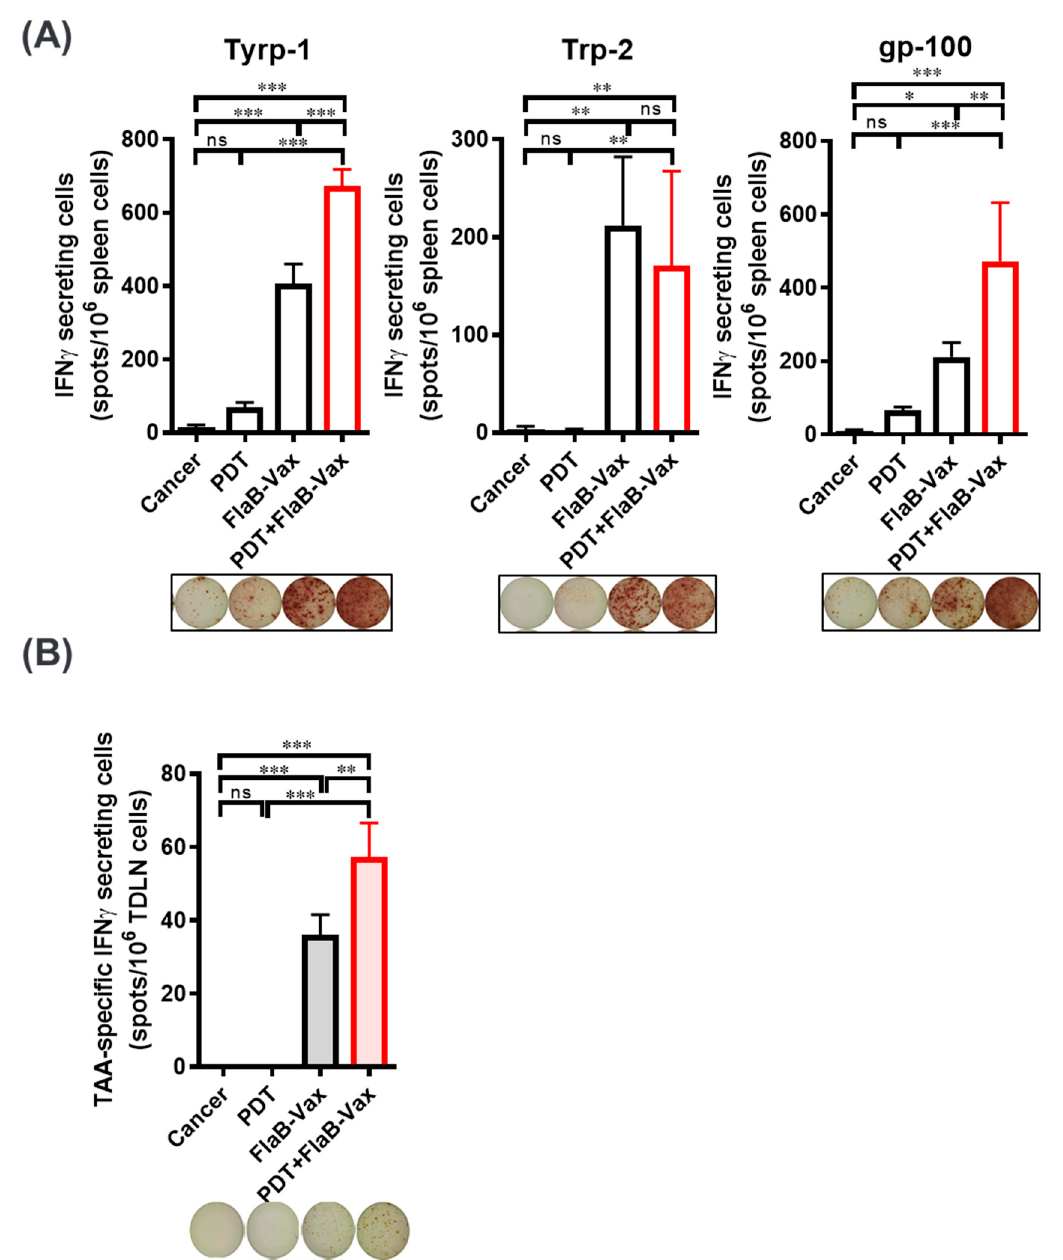
Figure 2. The combination of PDT and FlaB-Vax generates IFN γ -secreting antigen specific immune responses. Splenocytes ( A ) and tumor-draining lymph nodes (TDLNs) ( B ) were isolated from mice at day 7 after treatment, and then, the cells were stimulated with Tyrp1/Trp2/gp100 peptides to assess T cells secreting interferon γ (IFN γ ) by ELISpots. Splenocytes and TDLN cells were prepared from 4 and 3 animals, respectively. TDLN cells are stimulated by the mixture of three peptide antigens. The results are presented as the mean ± SEM ( n = 5 per group). *, p < 0.05; **, p < 0.01; and ***, p < 0.001.